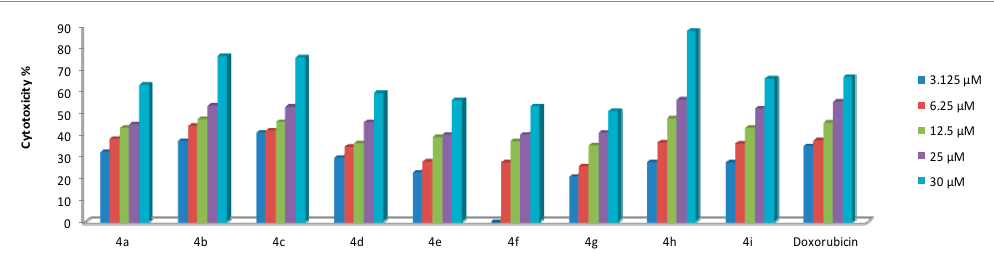
Figure 3. Dose dependent cytotoxic activities of new compounds on HCT-116 cancer cells according to the MTT assay.